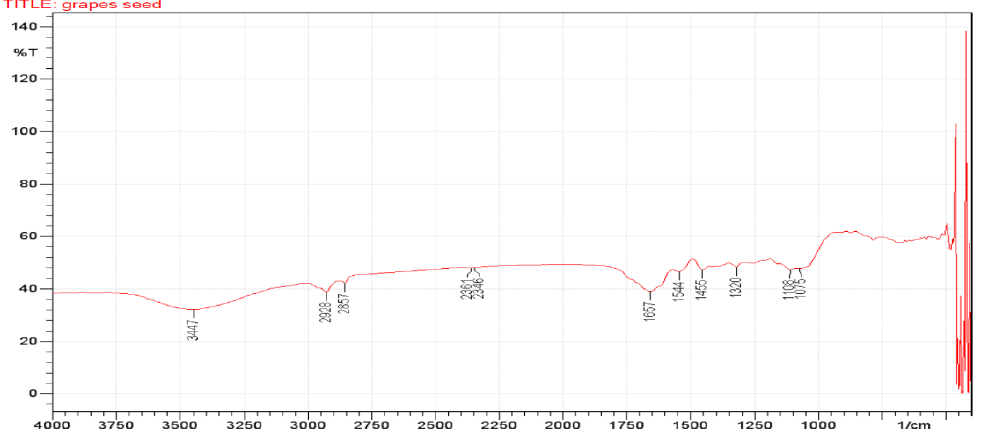
Figure 4. FTIR spectrum of grape seeds (GS).